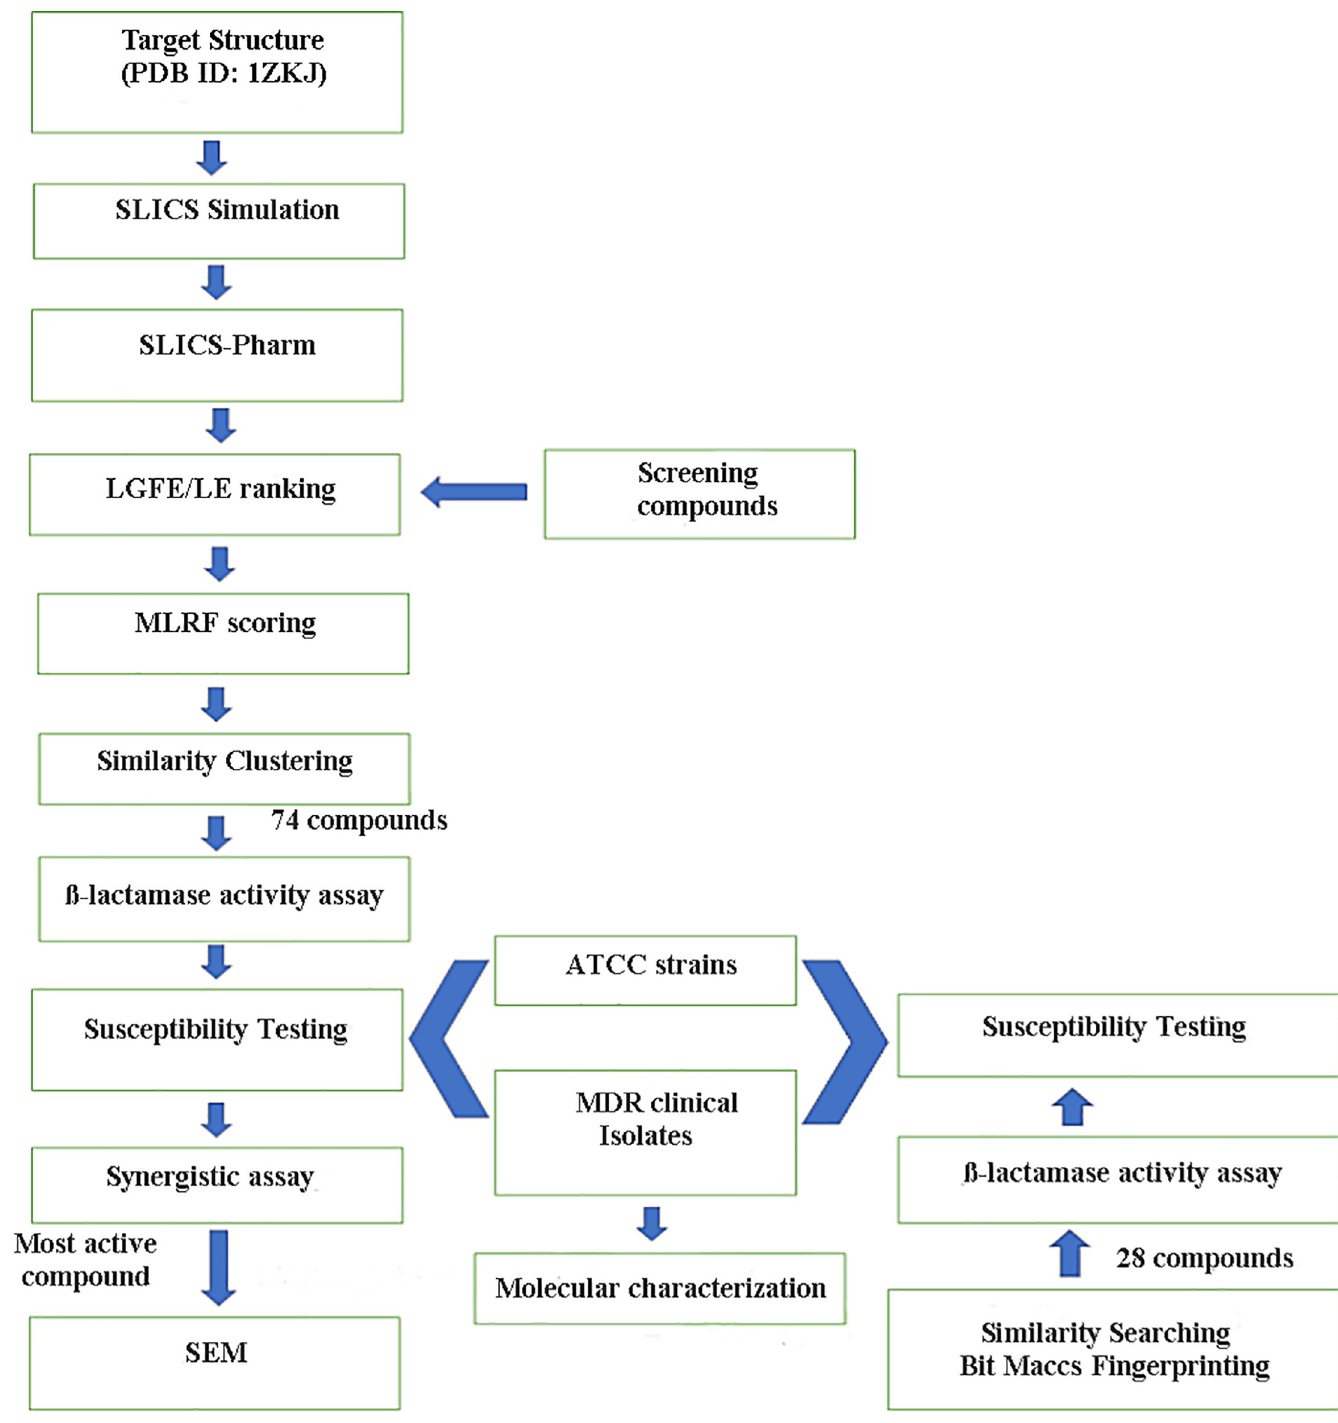
Fig 1. The computational screening and experimental validation protocol followed to identify putative CMY-10 inhibitors for combination therapy against multi-drug resistant Enterobacteriaceae.